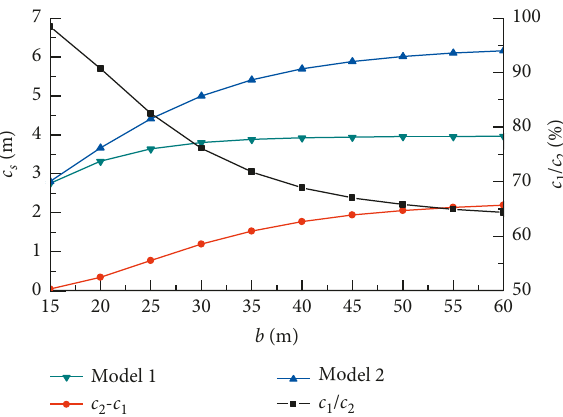
Figure 5: Diagram of the minimum thickness of the intervening pillar with the thickness of the overlying strata.